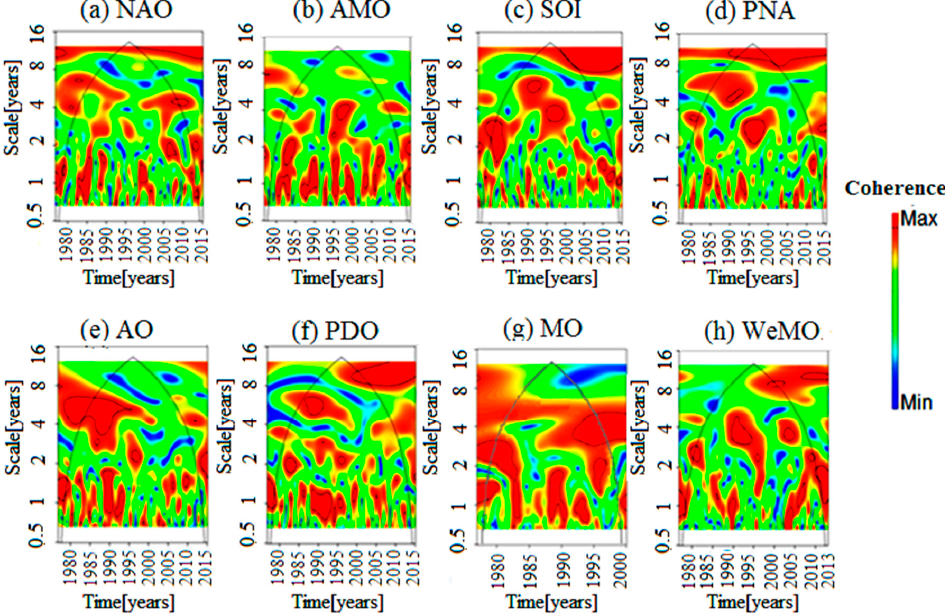
Figure 5. Spectrum of Wavelet coherence for climate indices and precipitation in station 1. ( a ) NAO: North Atlantic Oscillation, ( b ) AMO: Atlantic Multidecadal Oscillation, ( c ) SOI: Southern Oscillation Index, ( d ) PNA: Pacific–North-America teleconnection, ( e ) AO: Arctic Oscillation, ( f ) PDO: Pacific Decadal Oscillation, ( g ) MO: Mediterranean Oscillation, ( h ) WeMO: West Mediterranean Oscillation.